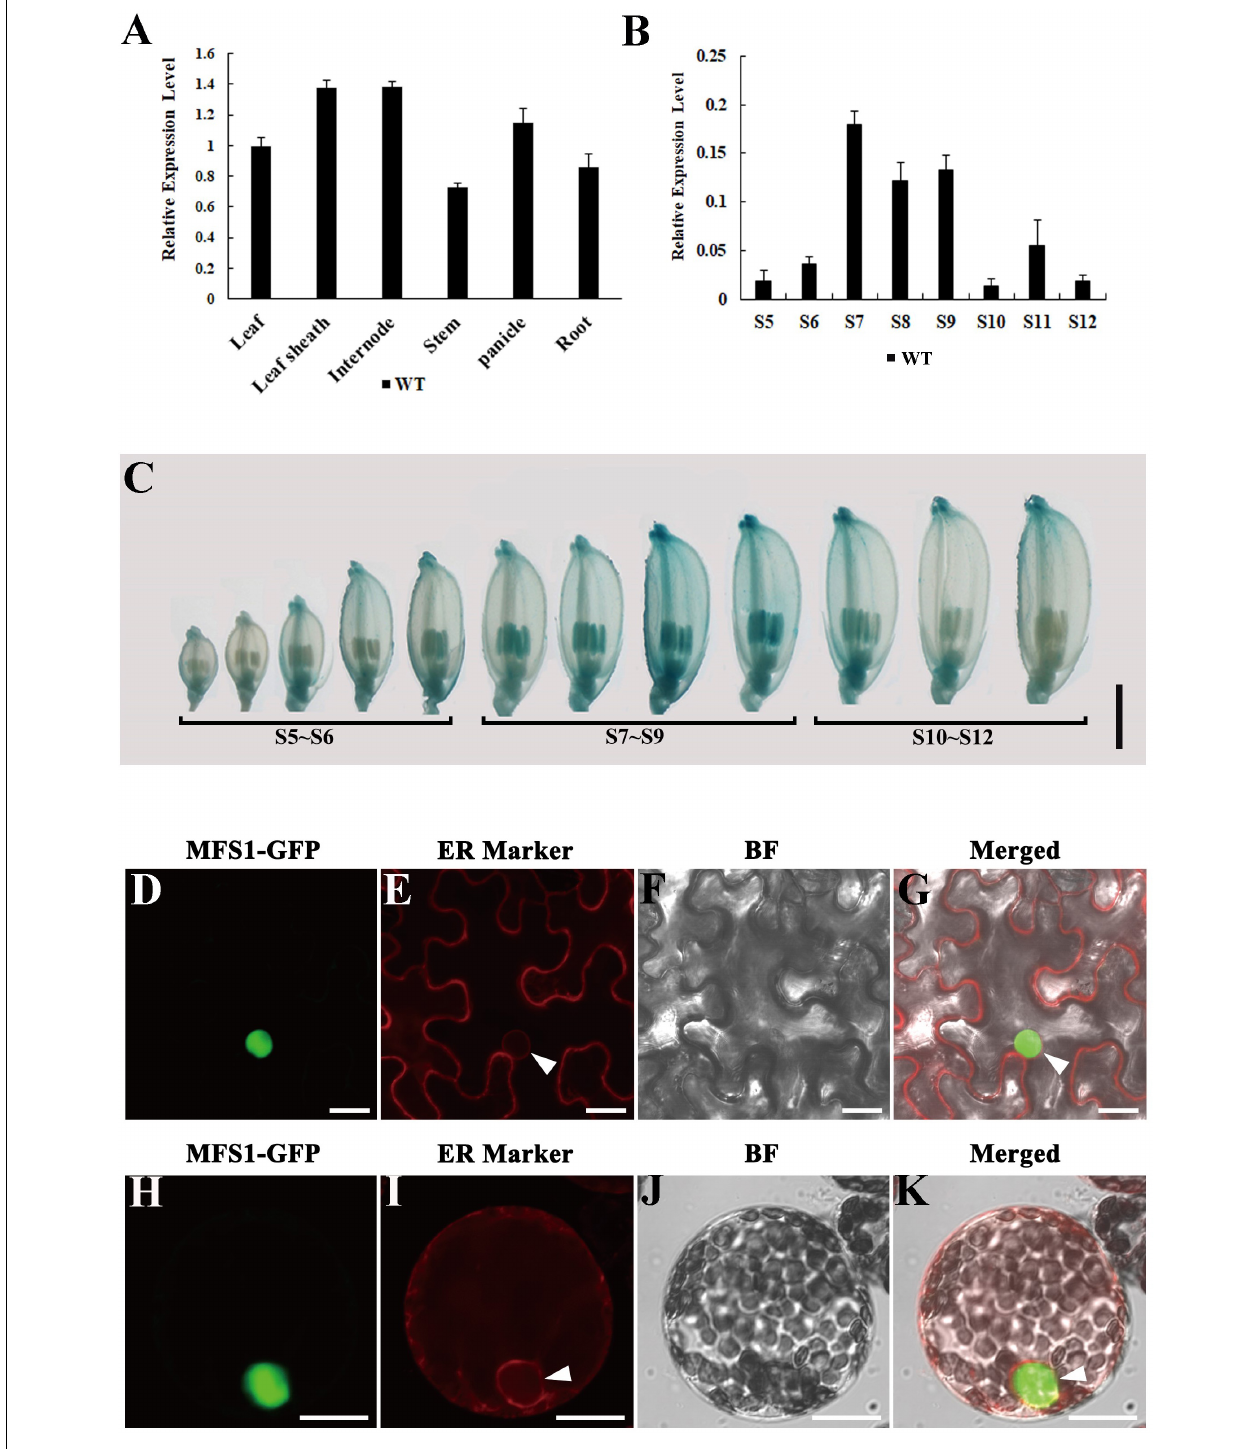
FIGURE 7 | Expression pattern analysis of OsMFS1 and subcellular localization. (A) The result of quantitative RT-PCR of the OsMFS1 in various different tissues of the WT. (B) The result of quantitative RT-PCR of the OsMFS1 in different stage of WT anther. The results of panels (A,B) were performed with three biological repeats. (C) Indicating the expression stages of the panicles of OsMFS1 by GUS staining. Bars = 2 mm. (D–K) Subcellular localization of OsMFS1 protein in N. benthamiana . (D–G) Subcellular localization of the OsMFS1-GFP protein in the cells of leaf epidermal. (H–K) Subcellular localization of the OsMFS1-GFP protein in protoplasts. (D,H) OsMFS1-GFP is detected in the nucleus. (E,I) Localization of the ER marker. (F,J) images of Bright field. (G,K) Merged the images of panels (D–F, H–J ), respectively. Bars = 10 µ m.